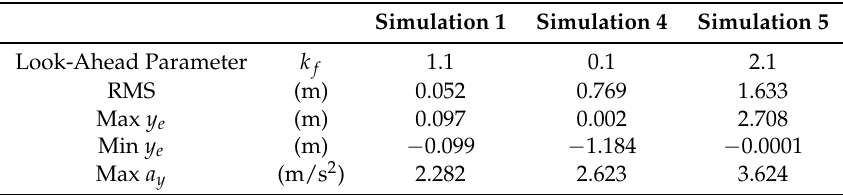
Table 4. Evaluation parameters for variation k f .